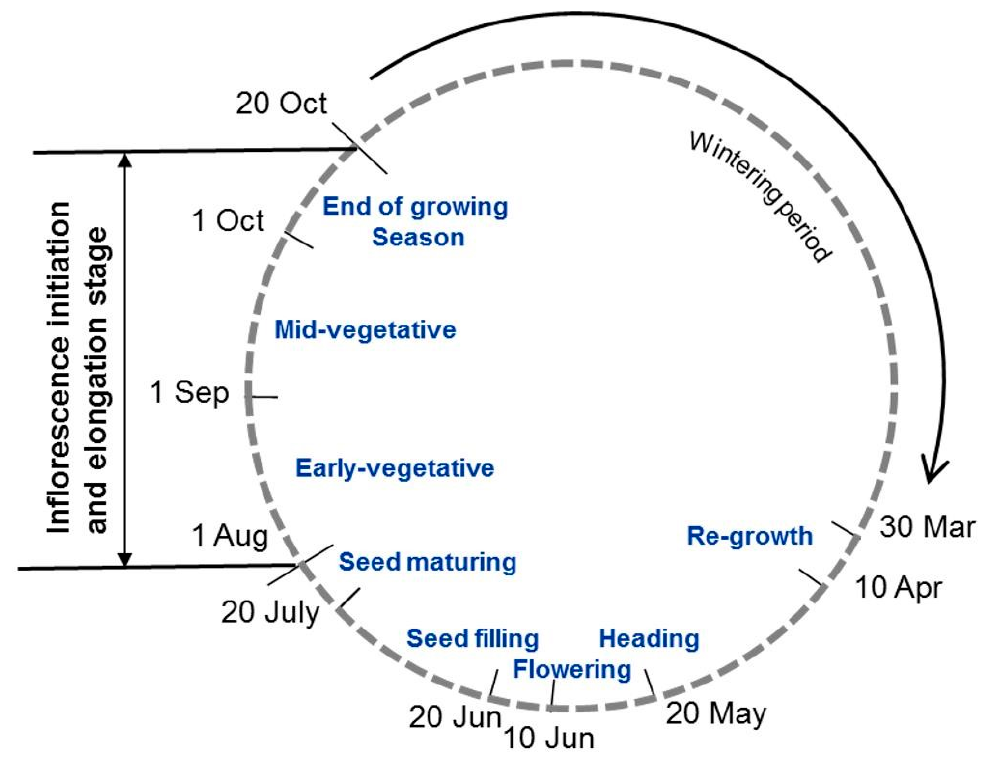
Figure 2. Phenological stages of Leymus chinensis . The figure has been cited from Shi et al. (2017).